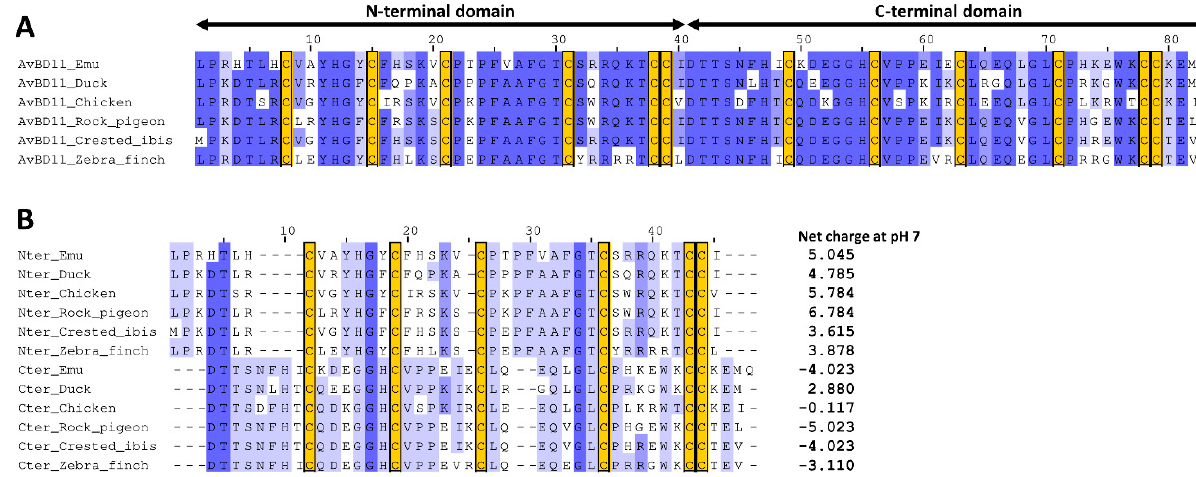
Figure 1. Multiple sequence alignments of AvBD11 and its two independent β -defensin domains in six evolutionarily distant birds (emu, duck, chicken, rock pigeon, crested ibis, zebra finch). ( A ) Mature AvBD11 protein sequences. ( B ) N-terminal (Nter) and C-terminal (Cter) domains of AvBD11. MSAs were performed with MAFFT and drawn with Jalview with a blue colour gradient (100% of identity for dark blue). Conserved cysteine residues are highlighted in yellow boxes.